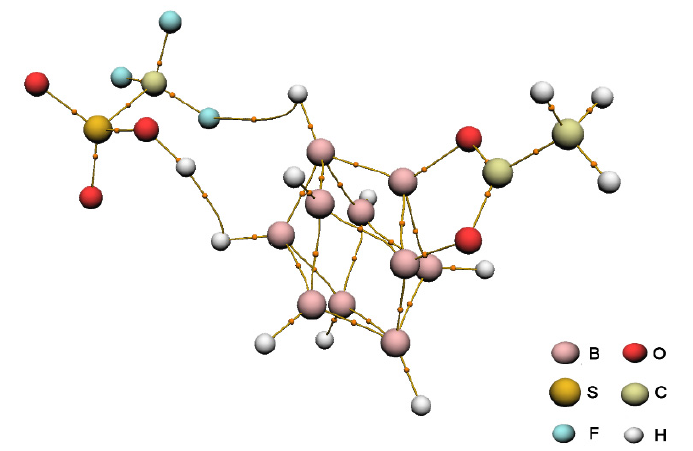
Figure 2. Molecular graph showing the results of the topological analysis of the electron density distribution in the model structure of the [2,6-B 10 H 8 O 2 CCH 3* CF 3 SO 3 H] −